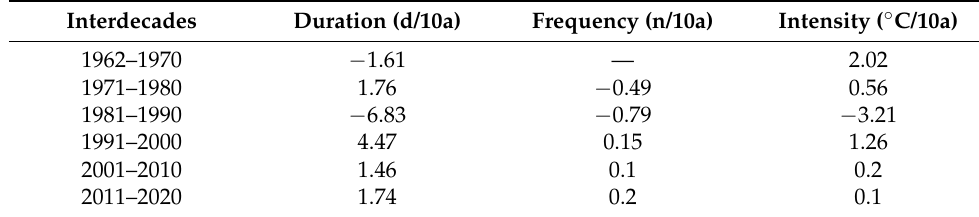
Table 1. Interdecadal trends in high-temperature heatwaves in Hexi